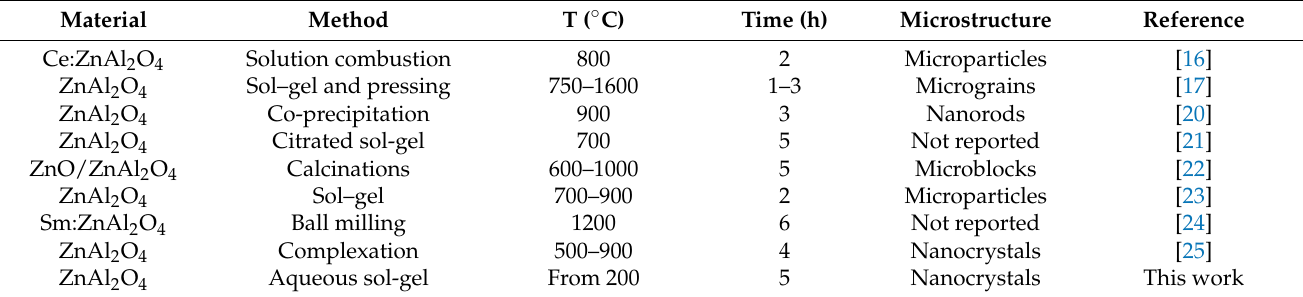
Table 2. Comparison of synthesis methods for the ZnAl 2 O 4